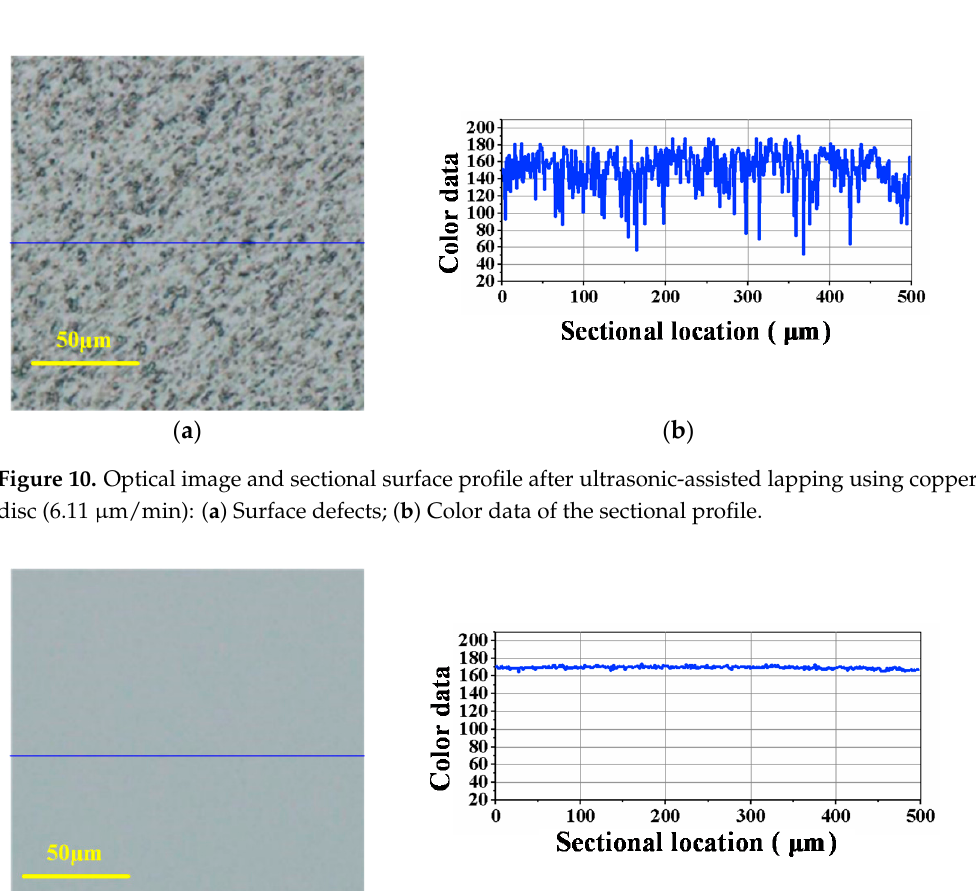
Figure 9. Optical image and sectional surface profile after ultrasonic-assisted lapping using cast iron disc (10.93 μ m/min): ( a ) Surface defects; ( b ) Color data of the sectional profile.